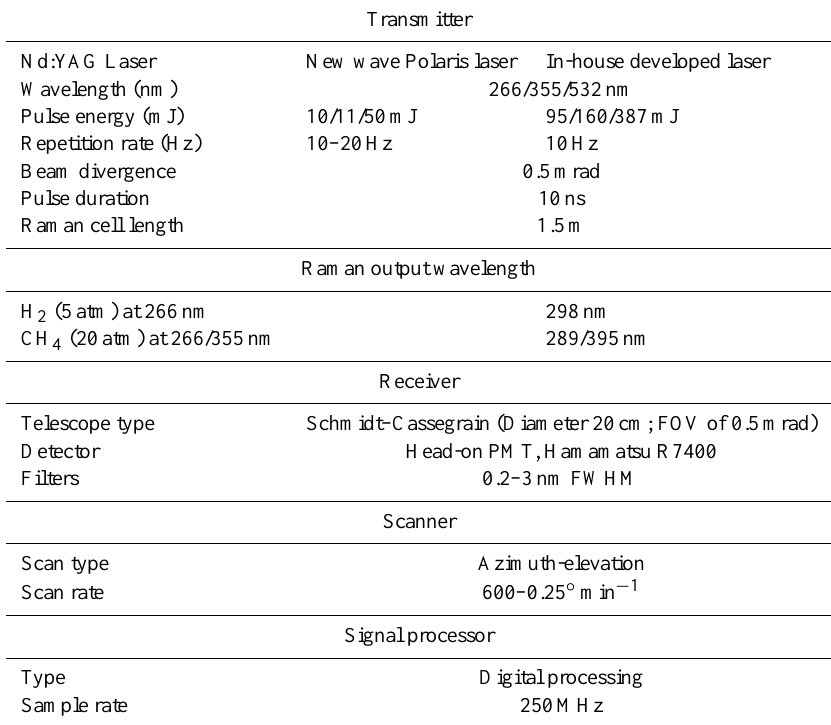
Table 1. Technical specifications of the scanning